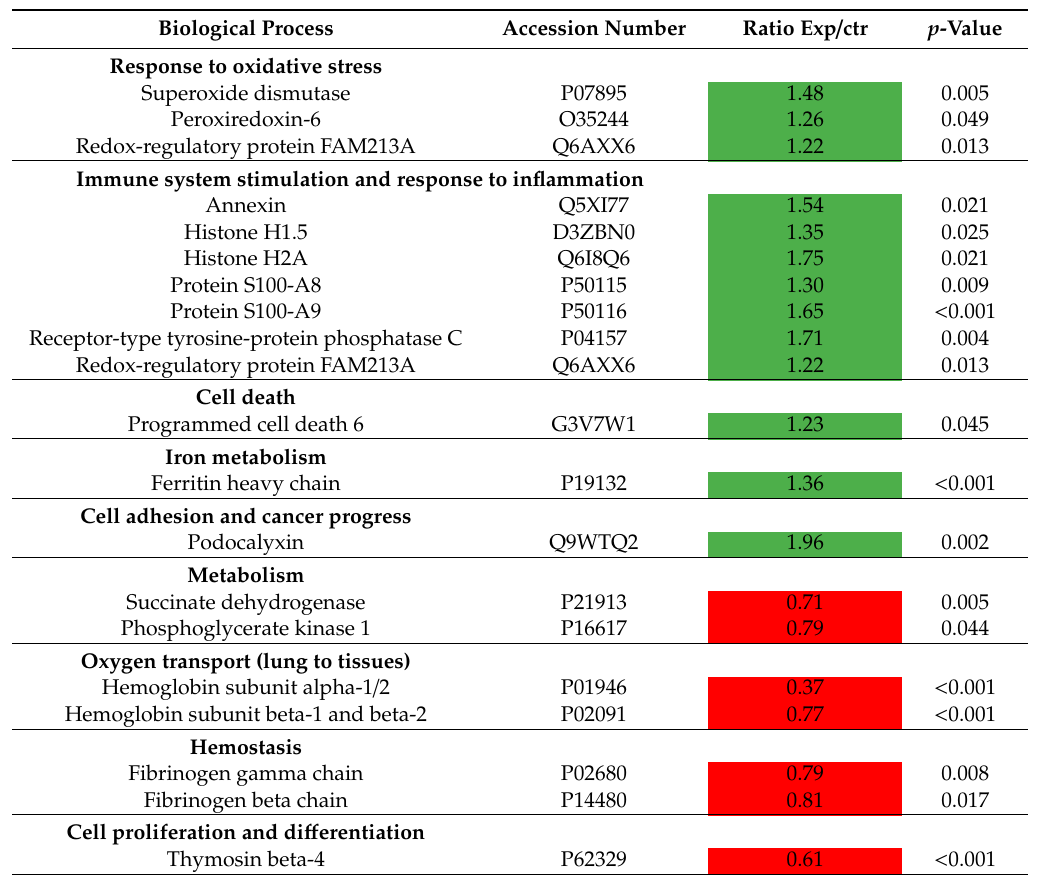
Table 6. Examples of dysregulated proteins in the lung following exposure to Iron NPs and corresponding biological processes. The data were generated from TargetMine software: Biological process name, protein name, protein accession number, ratio exposed (Exp) / control (Ctr), p -value ratio. Up-regulated proteins are highlighted in green color and down-regulated proteins in red color.